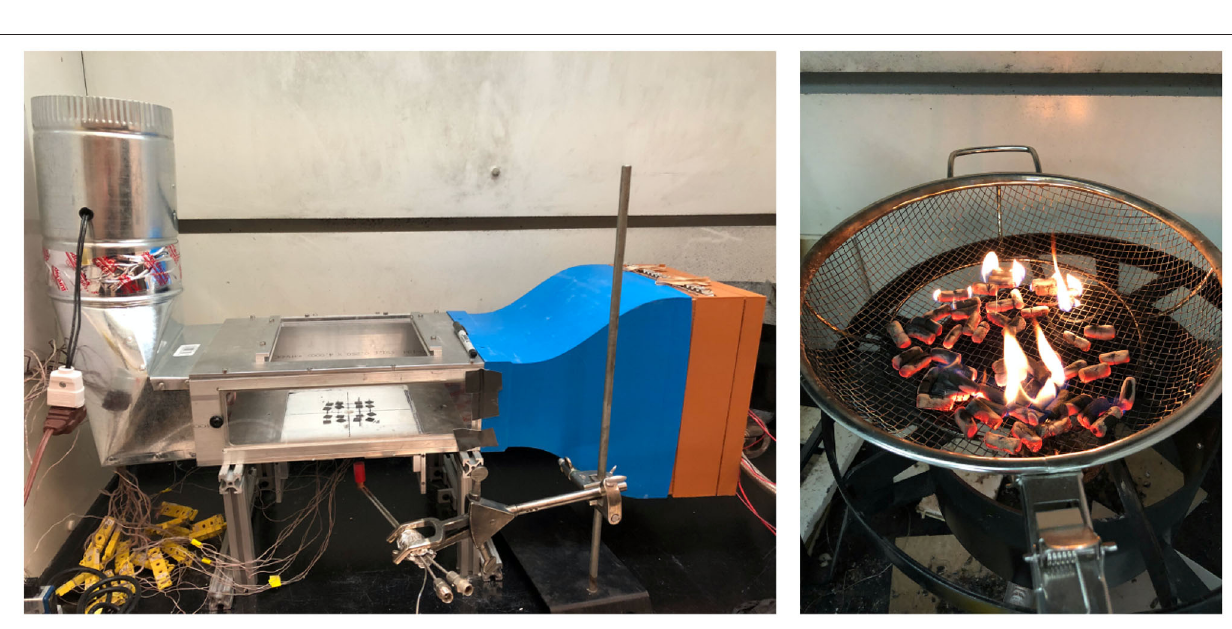
mass and geometry measurements of a sampling of cut